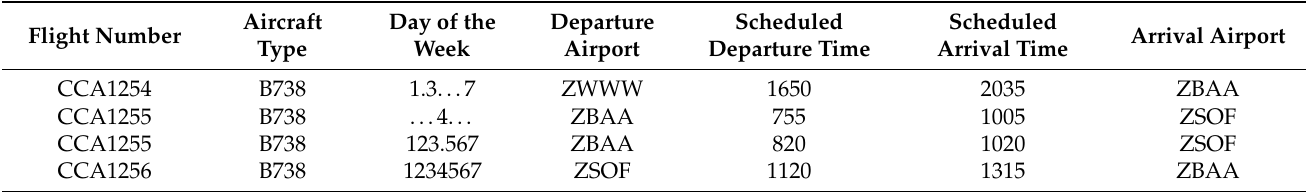
Table 3. An example of a flight schedule.